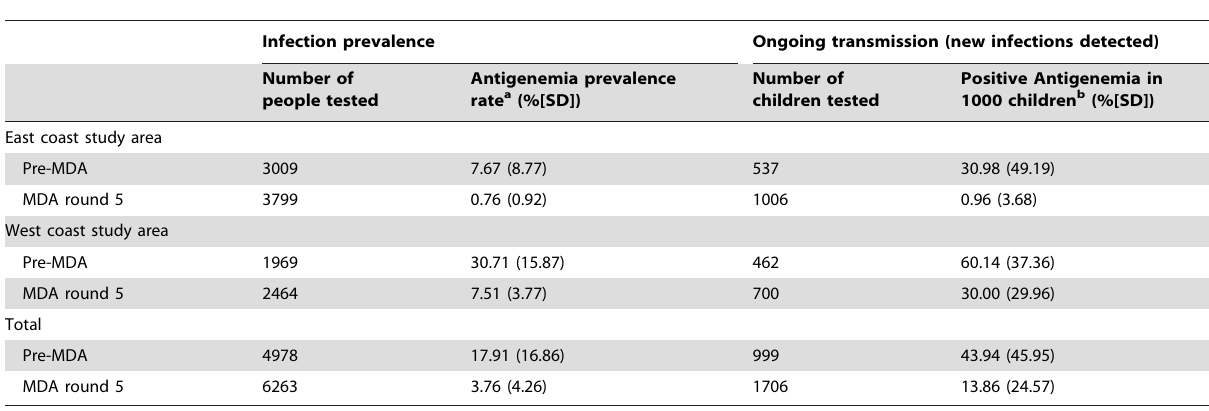
Table 1. Effect of MDA on circulating filarial antigenemia prevalence rates on Lihir Island.